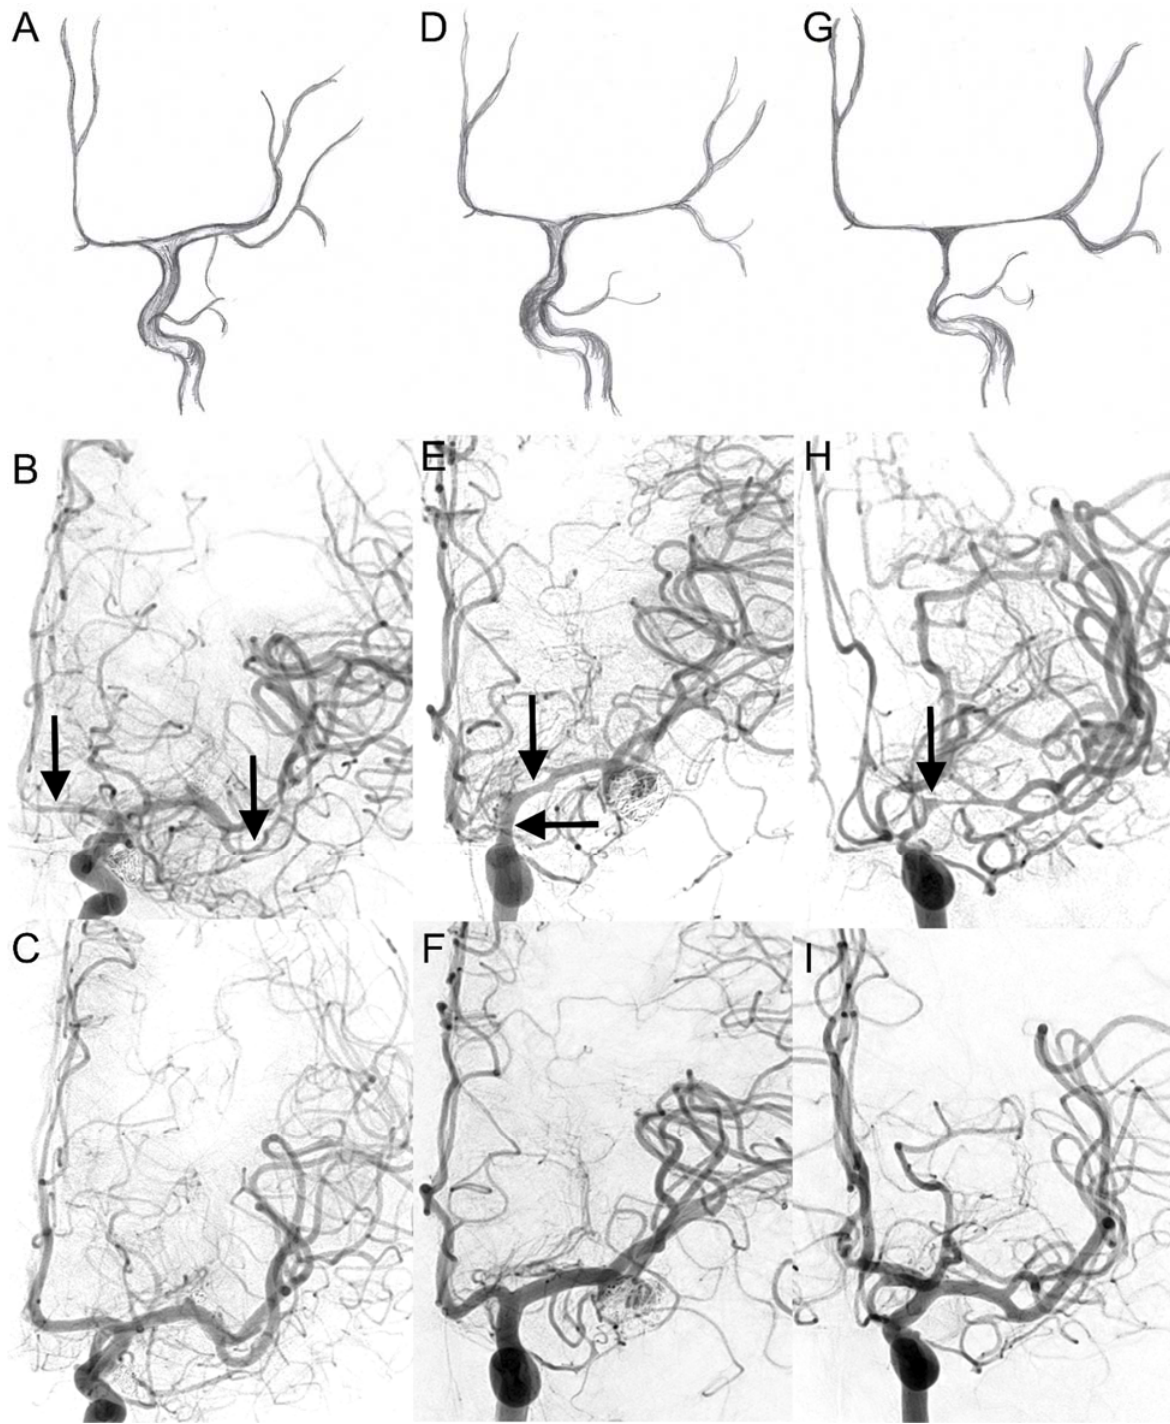
Figure 1. Visual cerebral vasospasm classification in digital subtraction angiography. The upper two lines display cerebral vasospasm grades (CVSG) as drawings with the corresponding angiograms. In the bottom line, the corresponding control DSA after six months is shown: ( A , B ) CVSG 1—Narrowing of the A2, A1, and M2 segments (arrows) with postspastic enlargement of distal M2 branches. ( D , E ) CVSG 2—The spasm affects the proximal M1 segment and the intradural carotid artery (arrows). ( G , H ) CVSG 3—The intradural carotid artery, the proximal middle cerebral artery, and the anterior cerebral artery show high ‐ grade narrowing with a fading appearance like a ghost (arrow). ( C , F , I )—control DSA after 6 months (CVSG 0).